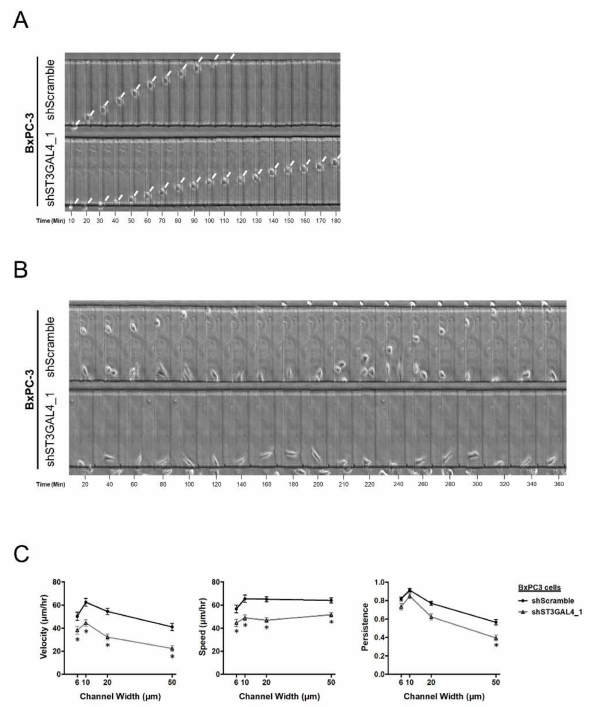
Figure 7. ST3GAL4 knockdown in BxPC-3 cells impaired cell migration inside microchannels. ( A ) Representative time lapse images depicting migration through 10 µ m-wide confined microchannels at 10-min intervals of BxPC-3 shScramble cells (top row) and shST3GAL4_1 BxPC-3 cells (bottom row). Arrowheads indicate the leading edge of a migrating cell. ( B ) Illustrative picture showing di ff erences in cell persistence between BxPC-3 shScramble cells (top row) and shST3GAL4_1 BxPC-3 cells (bottom row) migrating inside 50 µ m-wide unconfined microchannels in 20-min time intervals. ( C ) Migration velocity (left panel), speed (middle panel) and persistence (right panel) of scramble control and shST3GAL4_1 BxPC-3 cells in PDMS-based microchannels of 10 µ m in height, 200 µ m in length, and either 6, 10, 20 or 50 µ m in width. Data represent the mean ± SEM from at least 3 independent